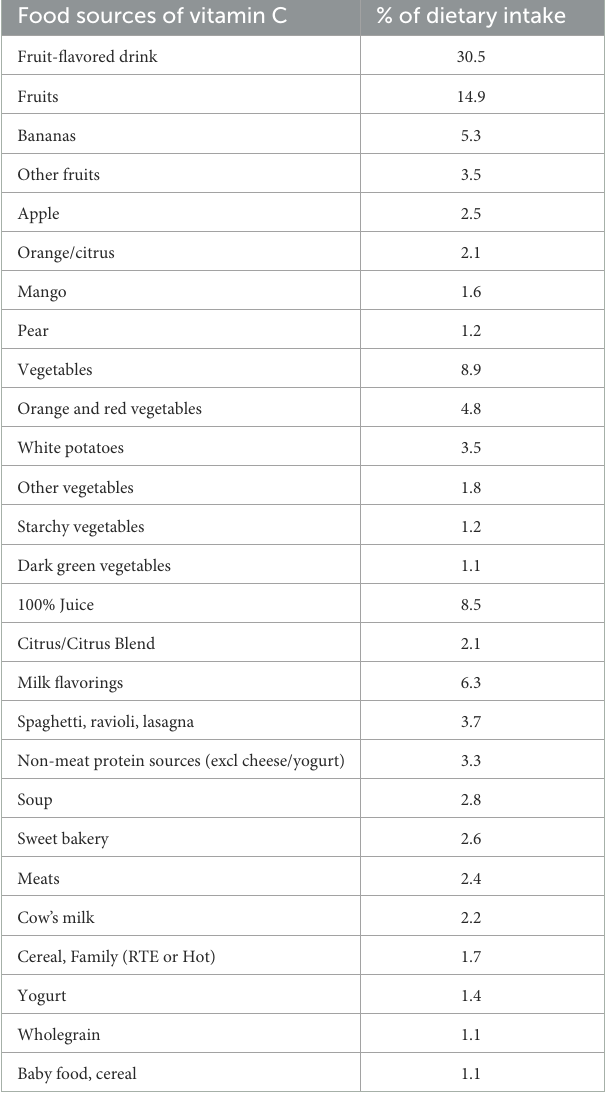
TABLE 4 Main dietary sources of vitamin C consumed by Brazilian children aged 4–8 years in the Northeast, Southeast, and South regions of the